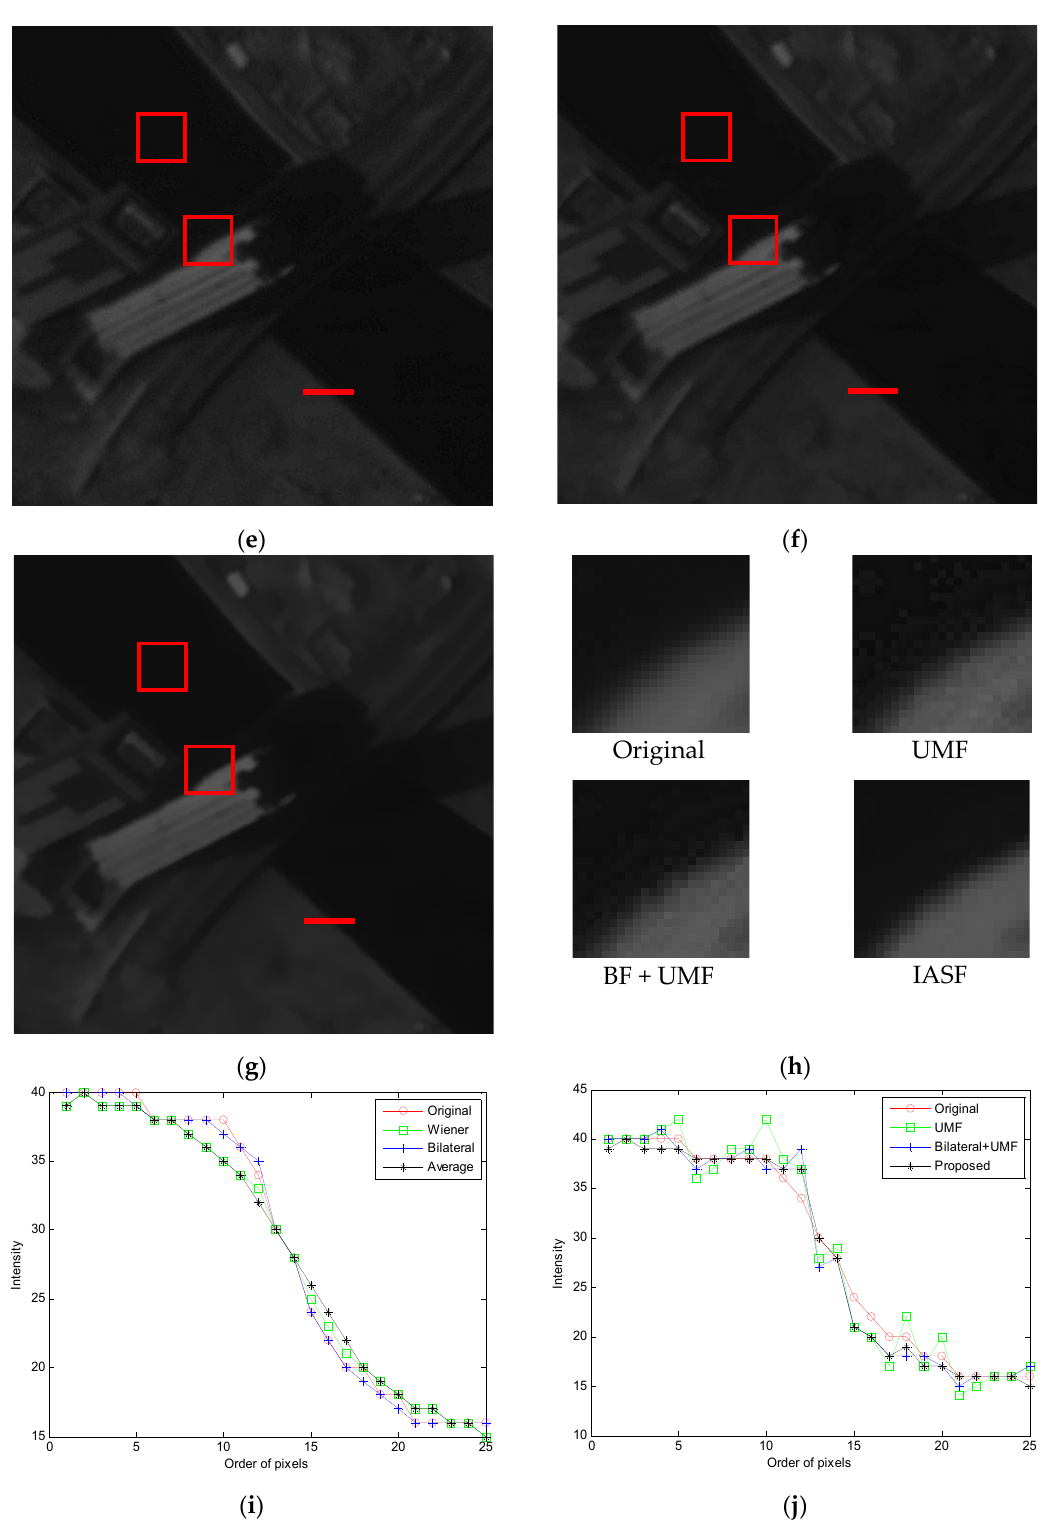
Figure 3. The raw image data of target 1 and its processed resultant images by different filters: ( a ) original data; ( b ) Wiener filter (WF); ( c ) average filter (AF); ( d ) bilateral filter(BF); ( e ) UMF; ( f ) BF + UMF; ( g ) IASF; ( h ) zoomed in images of box B; ( i ) gray level distributions of edge C for ( a – d ); ( j ) gray level distributions of edge C for ( e – g ).